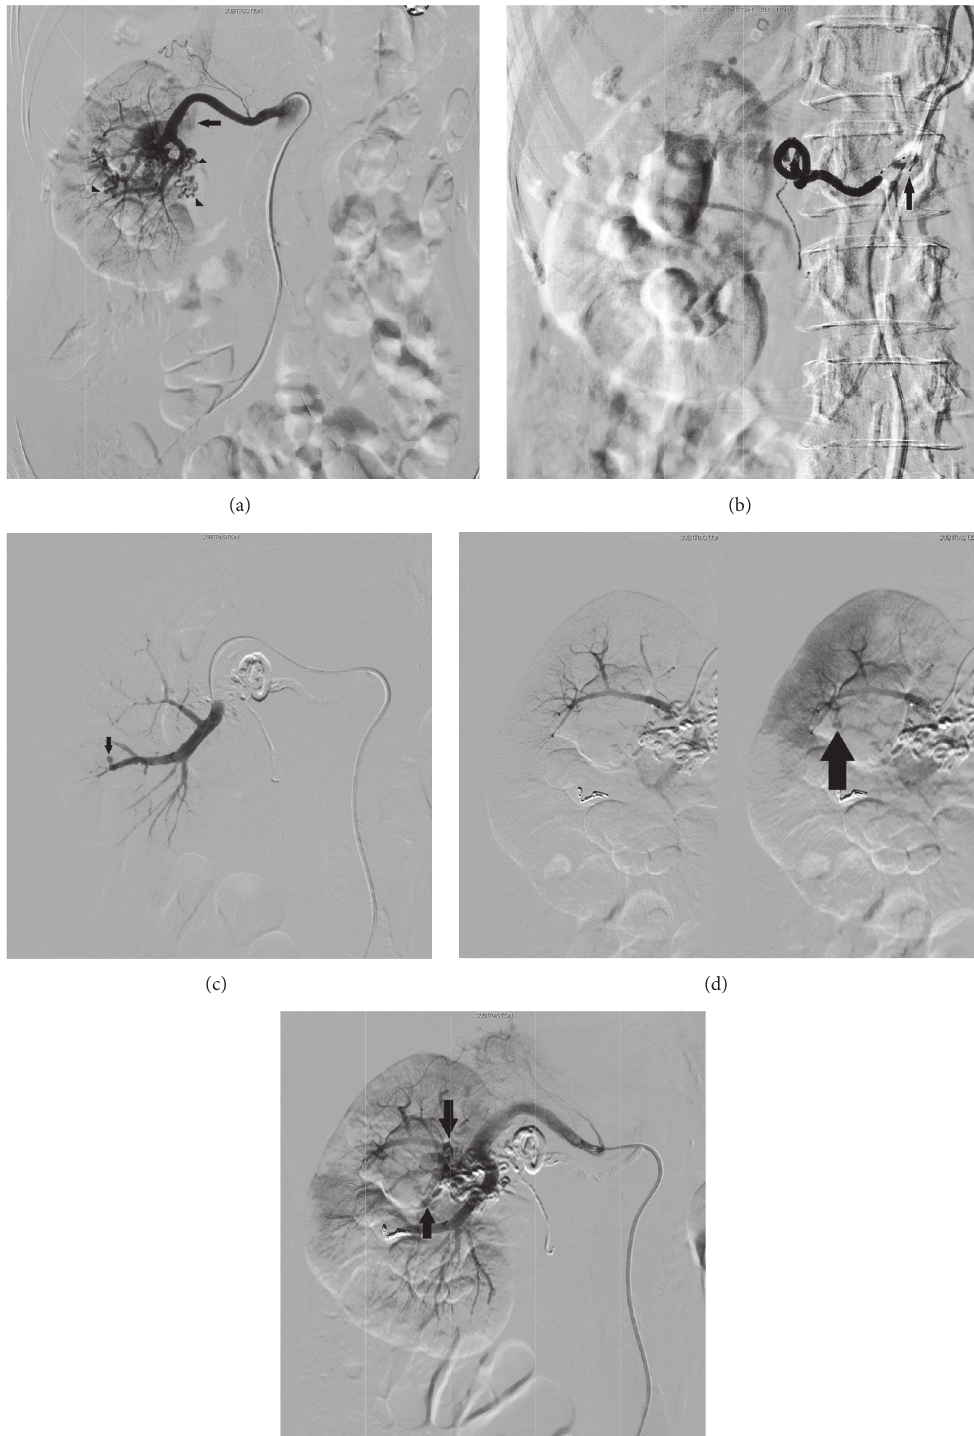
Figure 2: (a) Angiographic image obtained prior to embolization. Abnormal tortuous vessels (nidus) arise from the right renal artery (arrow heads). Early enhancement of inferior vena cava can be seen (arrow). (b) Embolization of abnormal vessels is performed from the ovarian artery using 0.8 cc of n-butyl-2-cyanoacylate (NBCA) lipiodol under arterial flow control by occlusion balloon (arrow). (c) Abnormal vessels from the renal lower segmental branch are embolized using a gelatin sponge and metallic coils. Extravasation to collecting system can be seen (arrow). (d) Extravasation to collecting system from the renal upper segmental branch (arrow). (e) Postembolization angiography. Minor abnormal vessels remain